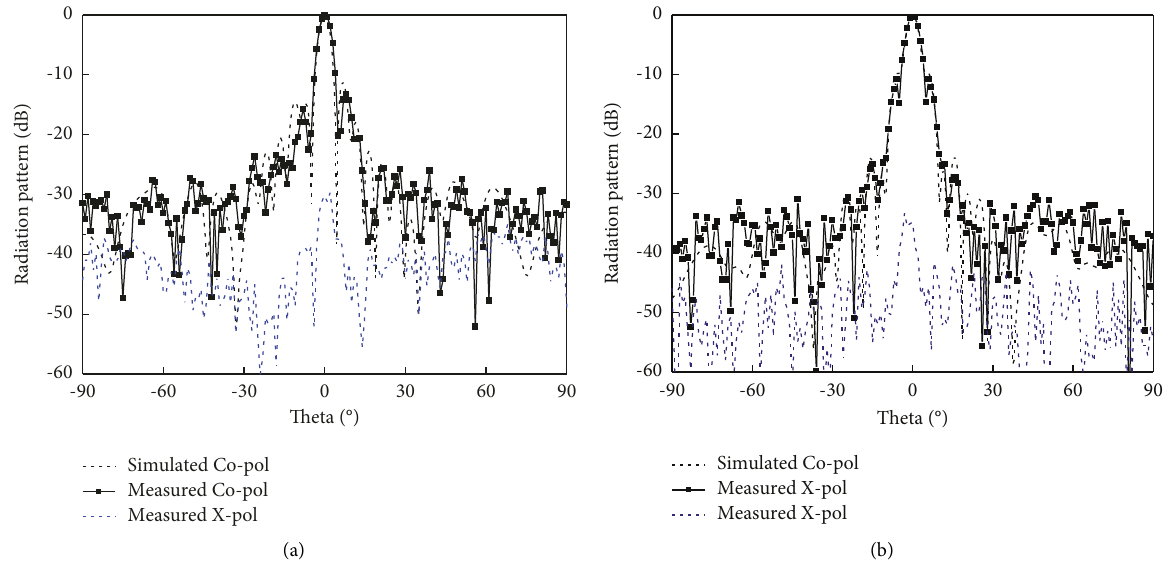
Figure 15: Normalized radiation patterns at 34.6 GHz. (a) E-plane. (b) H-plane.